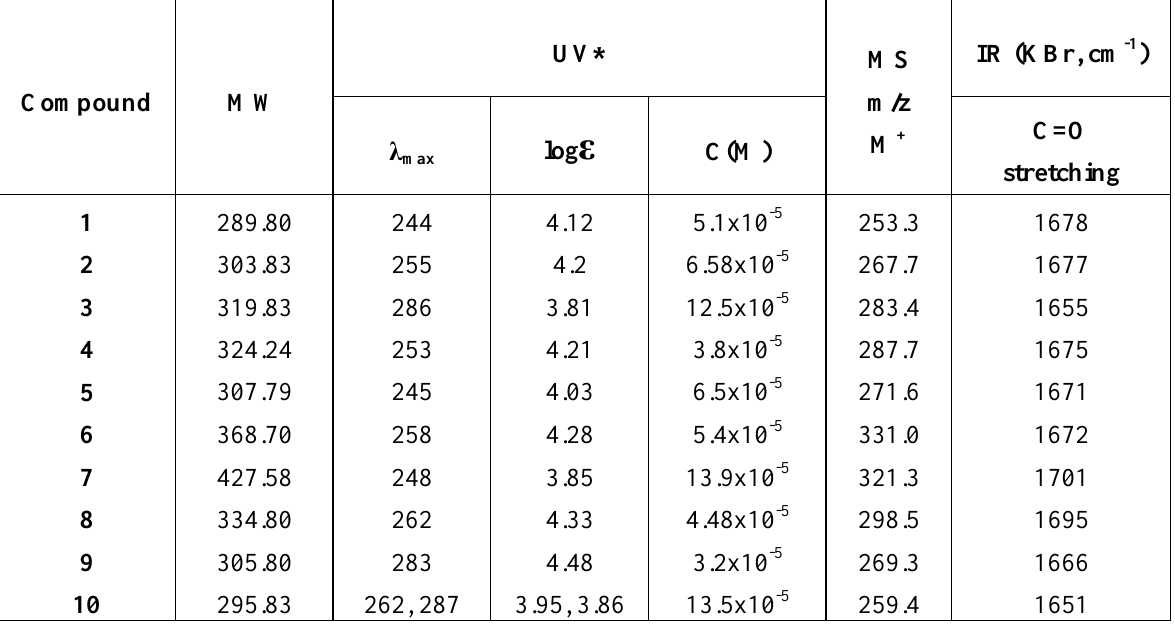
Table 2. UV, IR and MS results for the synthesized